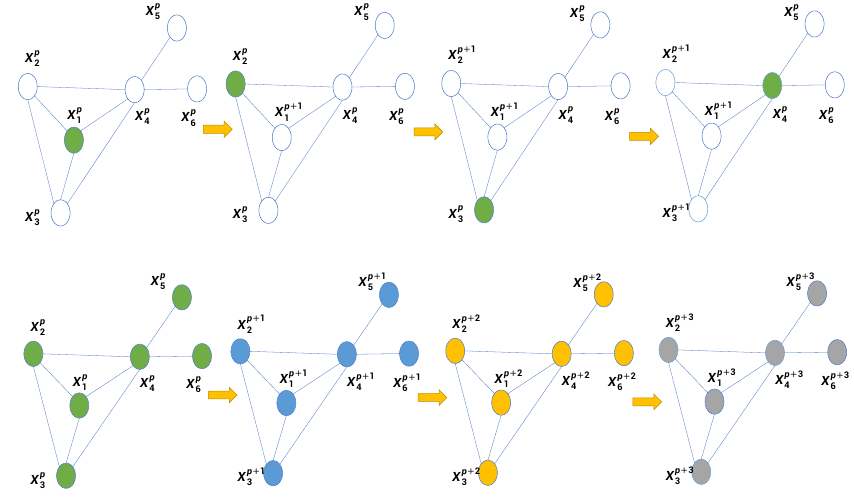
Figure 2. Sequential iteration ( top ) and parallel iteration ( bottom ). X p node after p − th iteration.